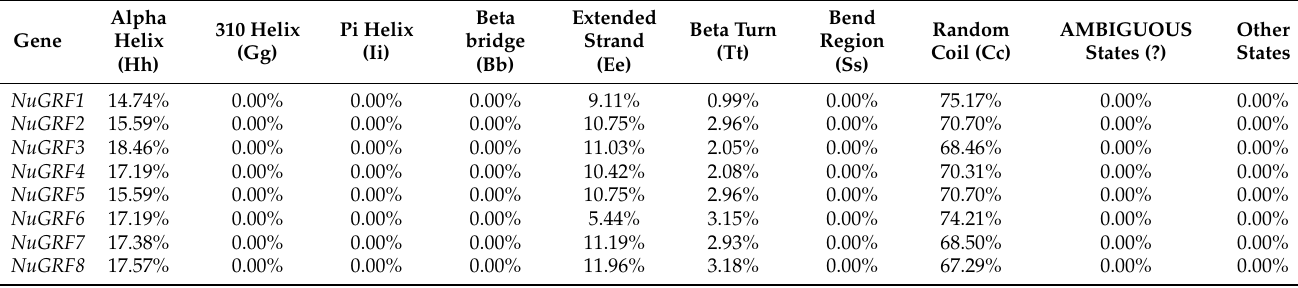
Table 2. Secondary structure of NuGRF